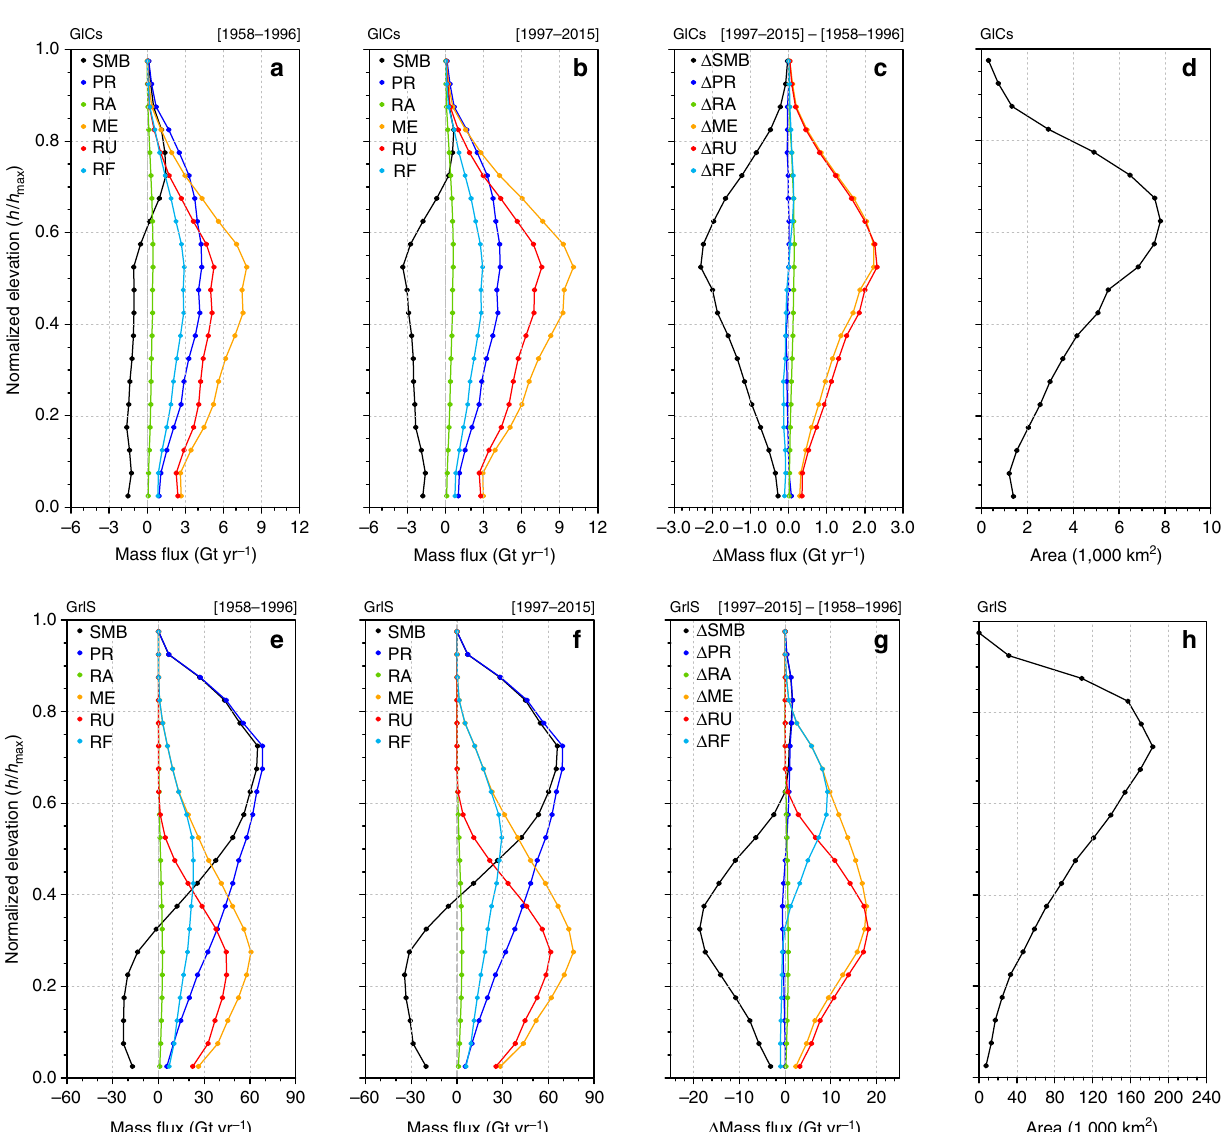
Figure 4 | Shrinking of the accumulation zones. Vertical profiles of surface mass fluxes integrated over GICs (upper row) and GrIS (lower row) elevation bins, scaled by the maximum height per region ( h max ), for the period 1958–1996 ( a , e ), 1997–2015 ( b , f ) and the difference between the two periods (1997–2015 minus 1958–1996, c , g ). SMB components are spatially integrated within normalized elevation bins ( h / h max ) of magnitude 0.05. For the GICs, SMB components are first integrated in elevation bins over twelve individual regions, each with different h max (boxes in Supplementary Fig. 5); the GICs-integrated SMB components are obtained by summing the contribution of the 12 regions to each scaled elevation bin. ( d , h ) The scaled hypsometries, that is, total area occupied by each elevation bin, for the GICs and the GrIS, GICs that are physically or dynamically separated from the ice sheet (respectively the surface, resulting from closure of the surface energy budget, is used to melt CL0 and CL1 in ref. 21), we used the Programme for Monitoring of the Greenland snow and ice. Liquid water from melt and rain percolates through the firn column, and is either held as irreducible water or refreezes, progressively reducing pore space from bottom to top layers until the entire firn column turns into ice (900kgm (cid:2) 3 ) and no additional water can be stored. At this point, any additional water is assumed to run off. The model also includes a snow albedo scheme using prognostic snow grain size 28 ; a drifting snow routine accounting for sublimation and snow erosion 29 . For the contemporary Arctic simulation, RACMO2.3 was run at 11km and forced on a six-hourly basis by ERA-40 (ref. 30; 1958–1978) and ERA-Interim 31 (1979–2015) re-analyses. The ice mask and topography at 11km are based on a 5km Greenland DEM 32 . For more information about RACMO2.3, recent updates and evaluation see refs 14,33,34. Topography and ice mask . We used a downsampled version of the GIMP DEM 17 to downscale the output of RACMO2.3 to a 1km topography and ice mask (Supplementary Fig. 4a,b), obtained by averaging the original GIMP DEM at 90-m resolution. To distinguish between the ice sheet, including glaciers strongly connected to the ice sheet (corresponding to connectivity level CL2 in ref. 21), and